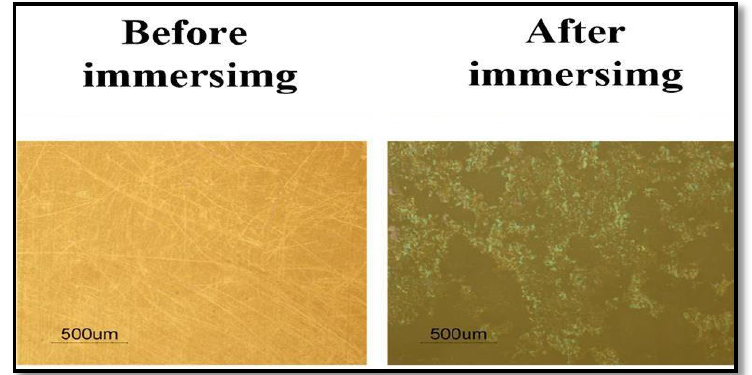
Fig. 7: The optical microscope images for the sample immersed in